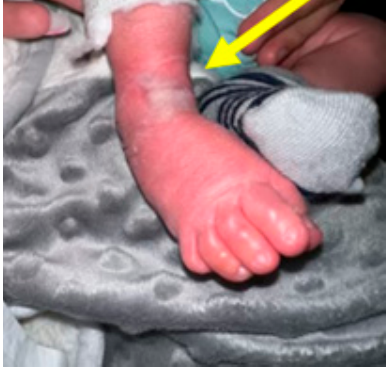
Figure 8. Clinical photograph showing an area of skin necrosis over the anteromedial aspect of the right ankle (pointed by the arrow) with swelling of the toes due to a cast that was too tight.